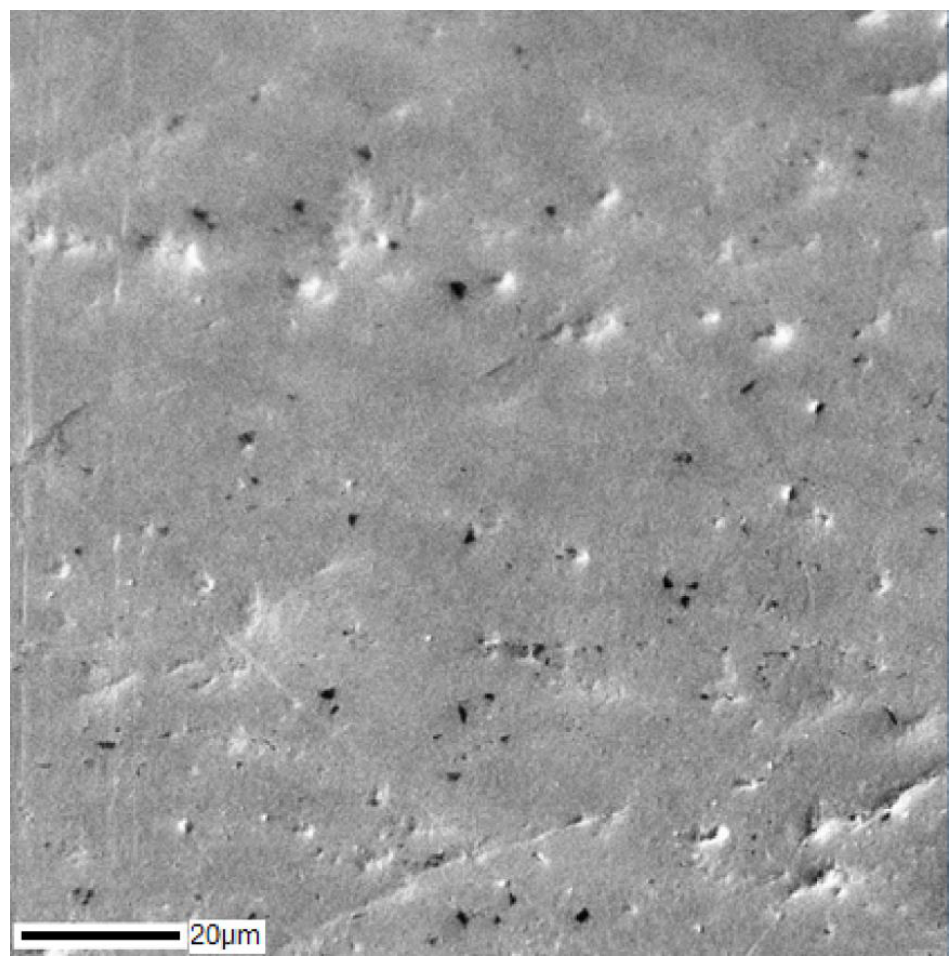
Figure 3. The structure of the Ti–28Nb–5Zr alloy after annealing at 900 °C for 12 h, obtained using SEM.